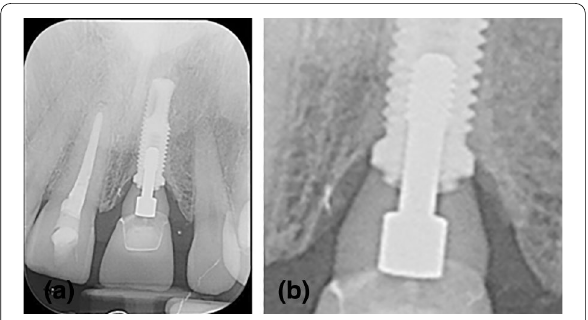
Fig. 2 a , b Subcrestally placed bone‑level butt‑joint implant with external hex connection ( a ) in a 10‑year control ( b )